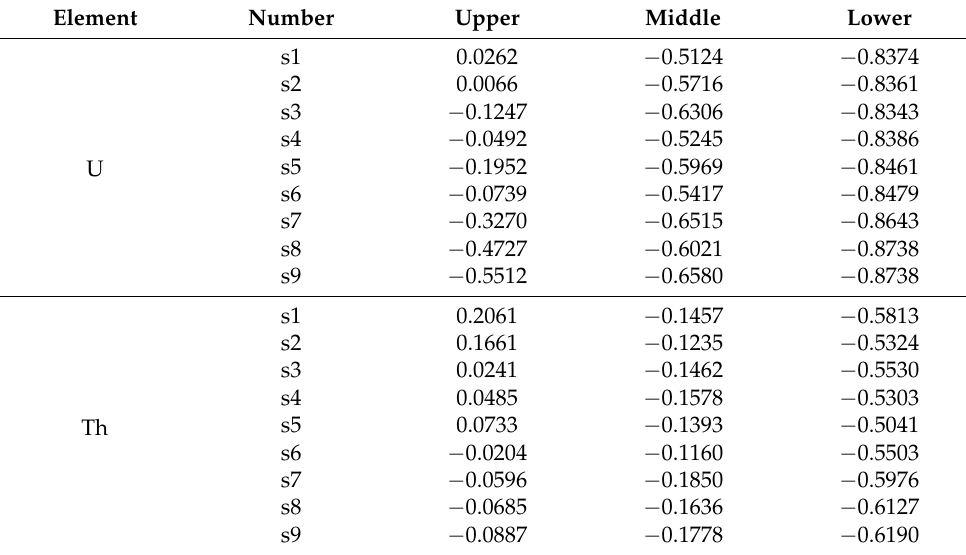
Table 4. Evaluation results by the index of geo-accumulation